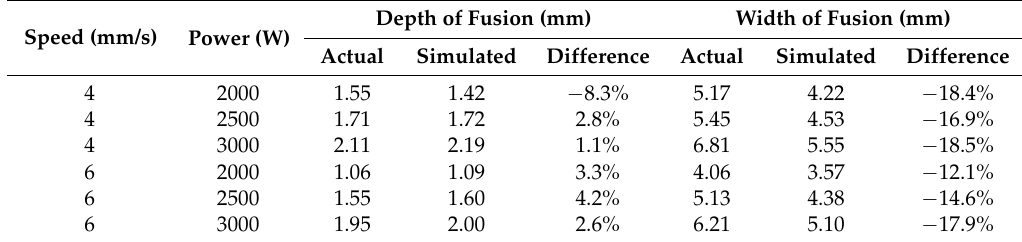
Table 4. Depth and width of the fusion zone, actual vs.